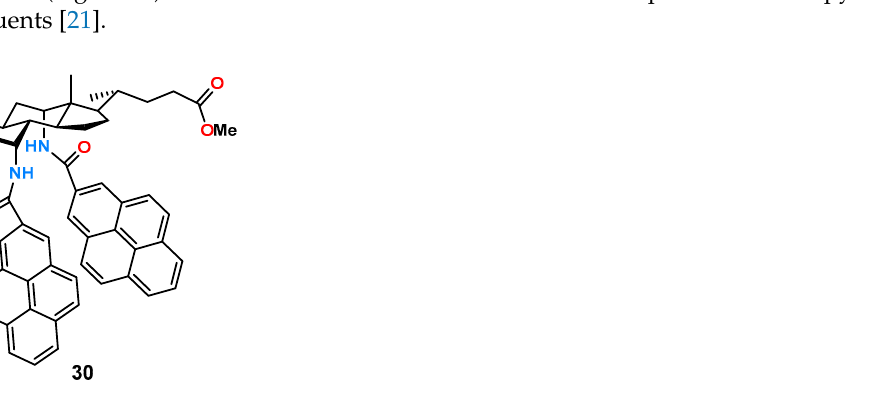
Figure 11. Receptor 30 based on cholic acid decorated with two pyrene fluorophores.